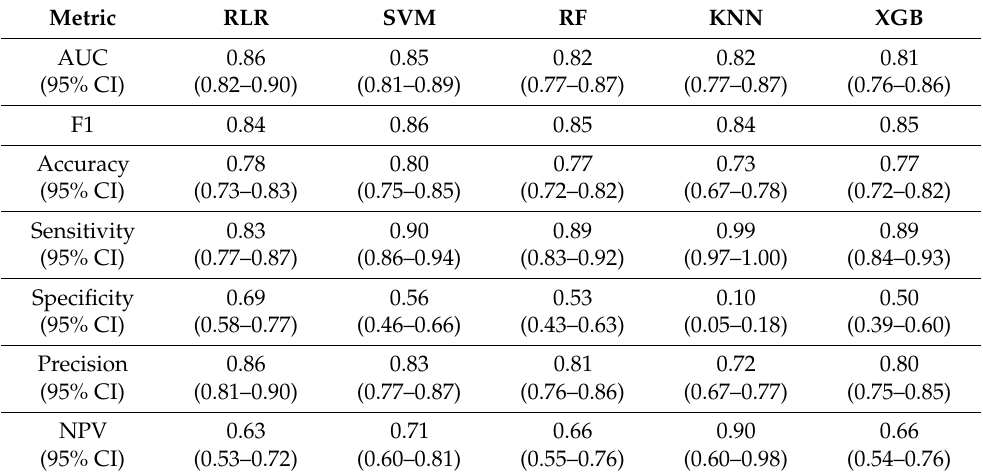
Table 3. Model performances of each machine learning model on the test dataset.